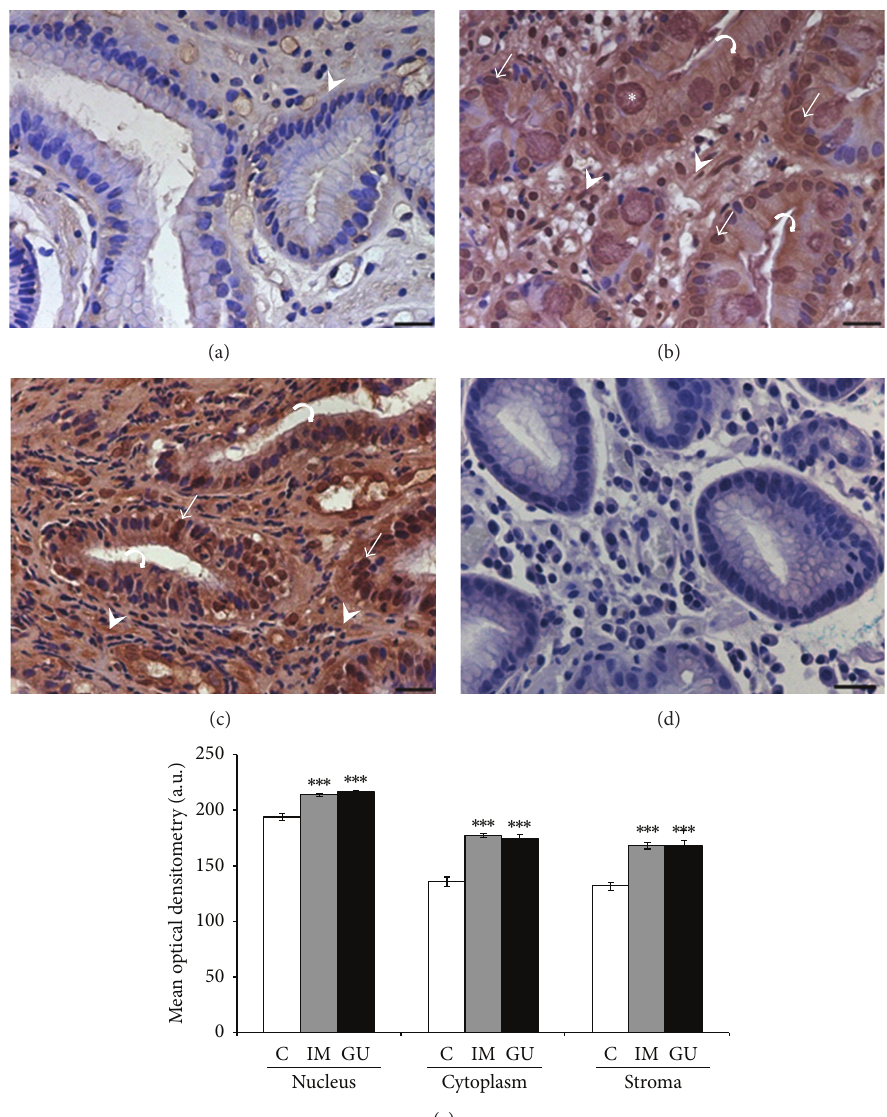
Figure 3: Expression of galectin-1 protein in the gastric mucosa (a–c). (a) Expression of Gal-1 in normal mucosa (C) in the stroma (arrowhead). (b) Intense immunostaining was observed in intestinal metaplasia (IM) in the nucleus (arrow), cytoplasm (curved arrow), and stromal region (arrowhead). (c) Peripheral area of gastric ulcer (GU) with high expression in stroma (arrowhead) and epithelial cells (curved arrow and arrow). (d) Absence of immunoreactivity in the reaction control. Asterisk: goblet cell. Hematoxylin of Harris counterstain. Bar: 20 𝜇 m. (e) Densitometry analyses (mean ± SE). ∗ 𝑃 in relation to C ( ∗∗∗ 𝑃 < 0.001 ). a.u.: arbitrary